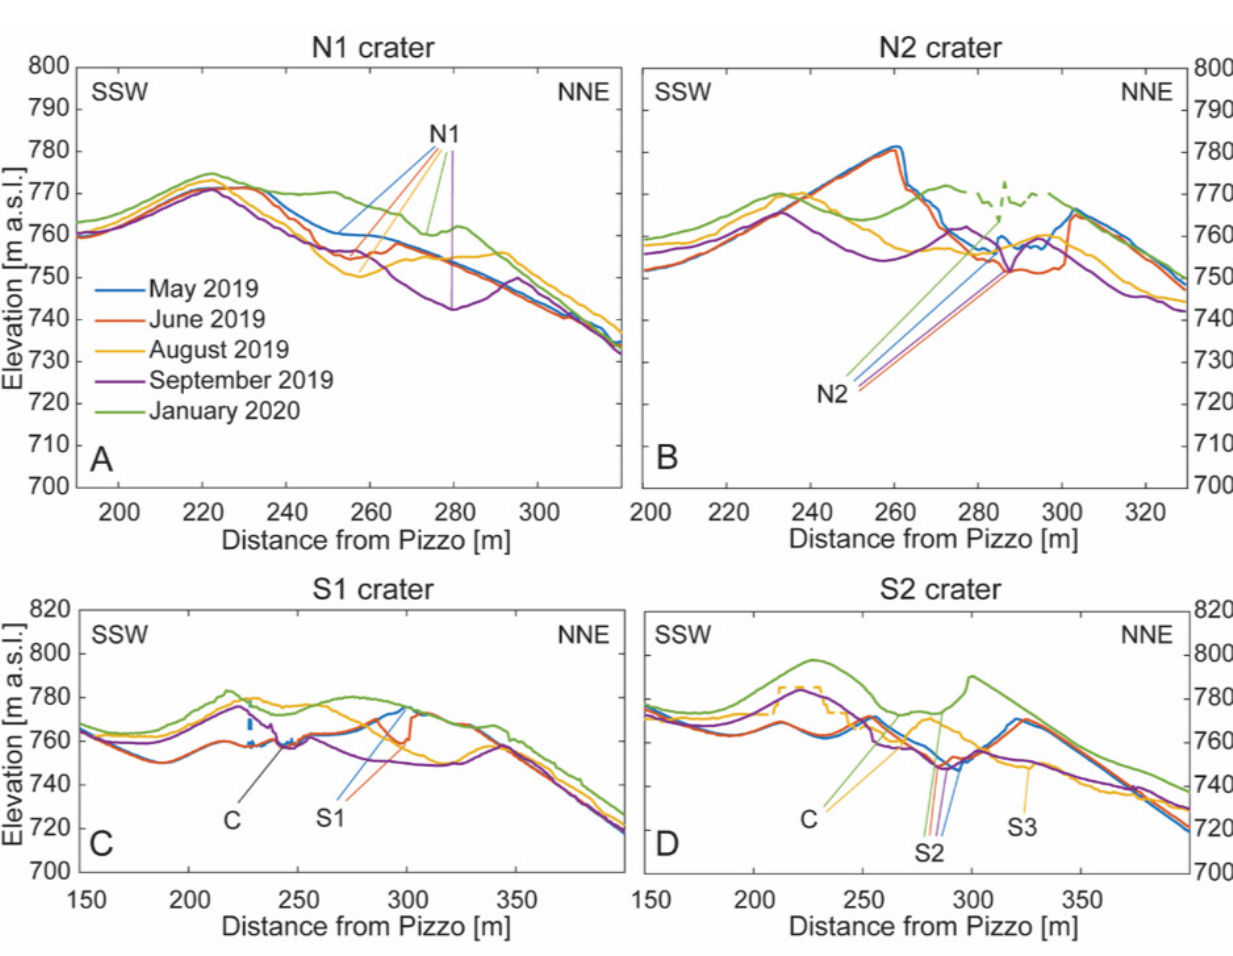
Figure 7: Transects through the craters of N1, N2, S1, and S2 as indicated in Figure 4 outlining the morphological evolution of the crater terrace. All transects start at the INGV thermal camera at Pizzo. Dashed lines indicate areas where artefacts influenced the